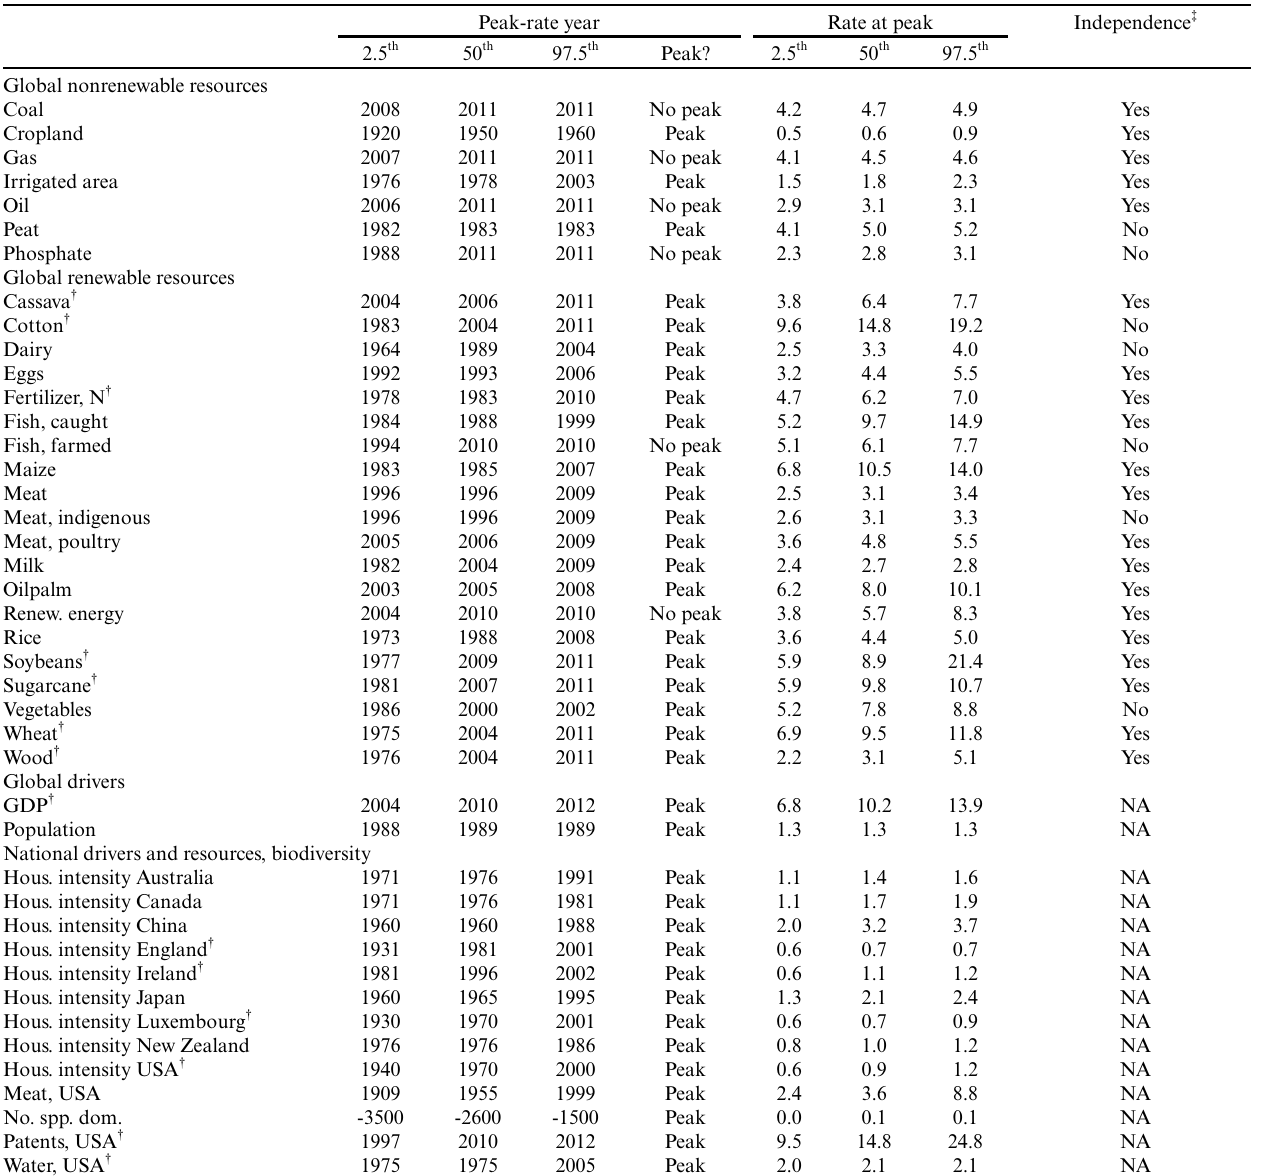
Table 3 . Lists of results for all resources and drivers: peak-rate year (50th percentile from the bootstrap distribution of year of the maximum of the first derivative of the spline smoothed bootstrap time series resample) of extraction of nonrenewable resources, harvest of renewable resources, and growth of drivers. When the 50th percentile is equal to the last year in the time series, it is concluded that no peak-rate year was detected, suggesting a still accelerating rate. The standardized growth rate at the peak-rate year with uncertainty is also